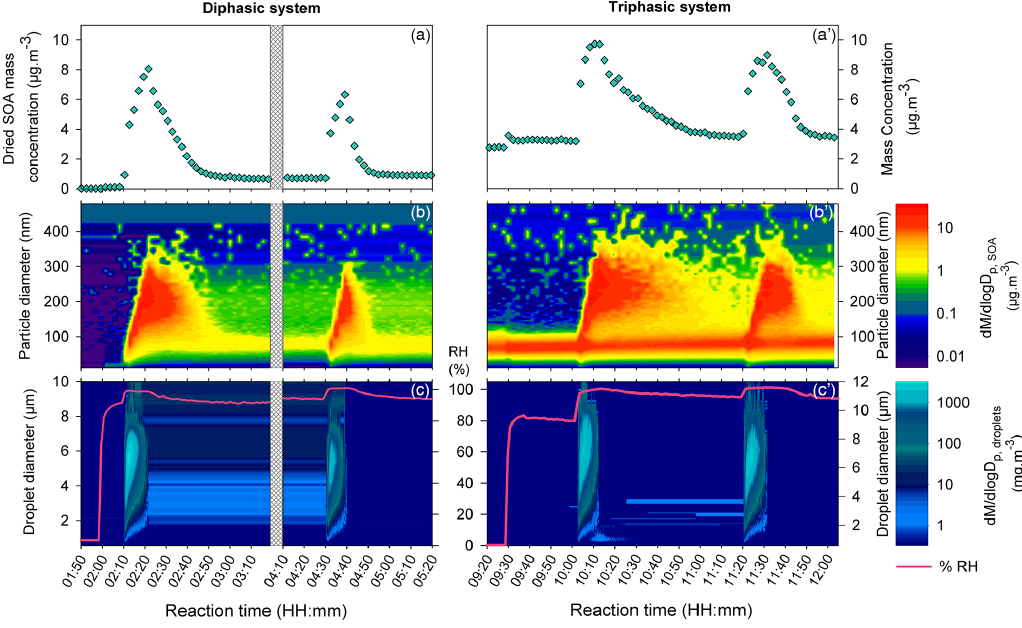
Figure 1. Effects of liquid phase clouds on SOA mass concentrations during two cloud events for typical diphasic (D300113, left panel) and triphasic (T280113, right panel) systems. Time profiles of ( a and a’ ) dried SOA mass concentration, ( b and b’ ) dried SOA mass size distribution, ( c and c’ ) cloud droplet mass size distribution and relative humidity in the simulation chamber. A particle density of 1.4µgm − 3 was